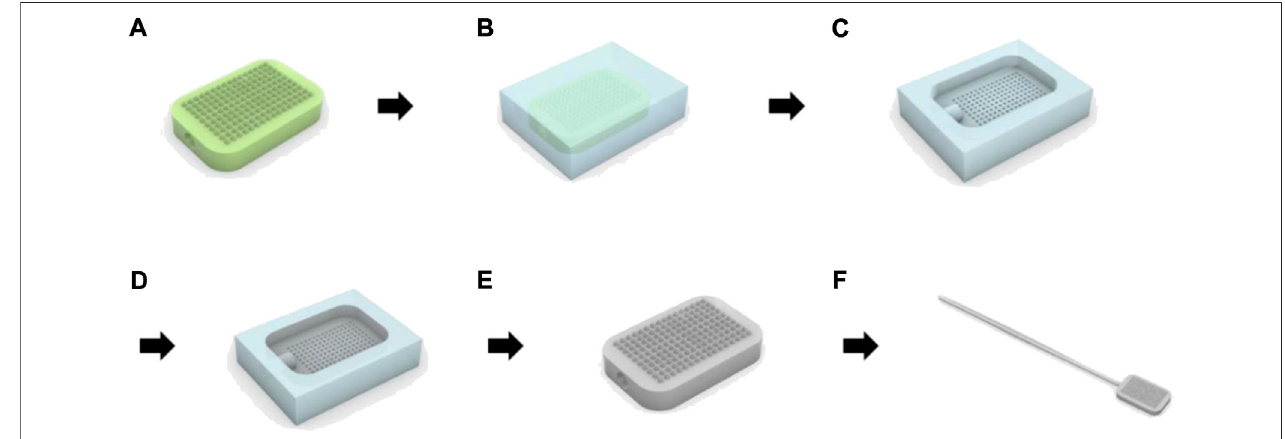
FIGURE 2 | Manufacturing process of microneedle swab using polymer melt micromolding. (A) Production of the master structure of the head with the microneedles by micro-milling or 3D printer. (B) Fabrication of PDMS (polydimethylsiloxane) mold. (C) Removal of the cured PDMS mold from the master structure. (D) Preparation of replicate using polymer micromolding process. (E) Removal of polymer replicates from PDMS mold. (F) Integration of the head with handle.